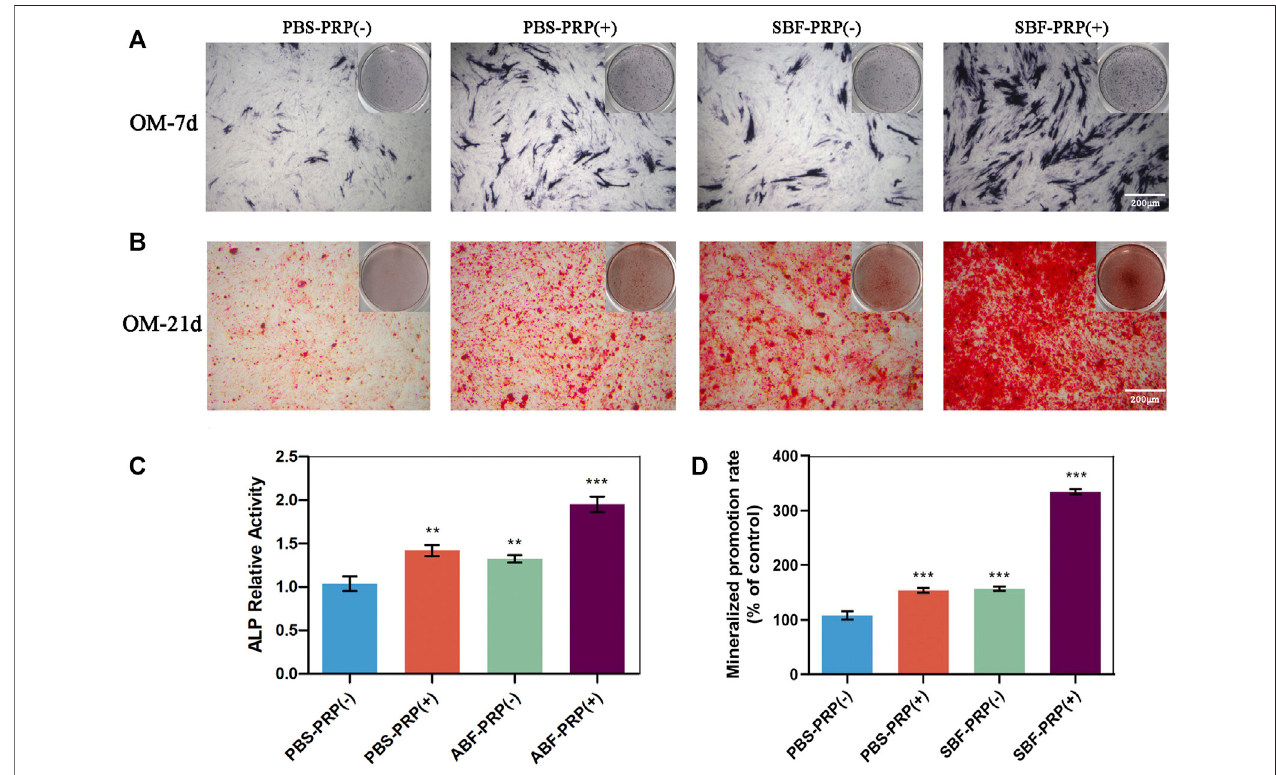
FIGURE5| ALPactivityandcalciumnoduleproductionofBMSCs. (A) ALPstainingofBMSCsafterosteogenicdifferentiationfor7 days. (B) Alizarinredstainingof BMSCsafter osteogenicdifferentiation for21 days. (C) ALPactivity levelofBMSCsafter osteogenic differentiation for7 days. (D) Quanti fi cation ofAlizarinred stainingin (B) . ( p p < 0.05; pp p < 0.01; ppp p <